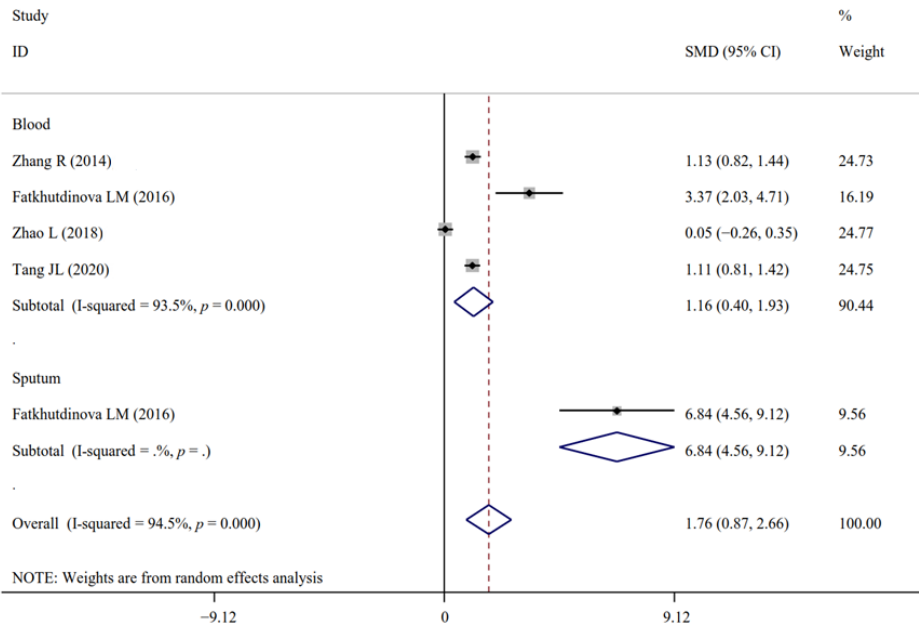
Figure 9. Forest plots assessing the effects of NM exposure on the level of IL-1 β in different samples compared with the non-exposed control group. NMs, nanomaterials; IL-1 β , interleukin-1 β ; SMD, standardized mean difference; CI, confidence interval [17,19,39,40].